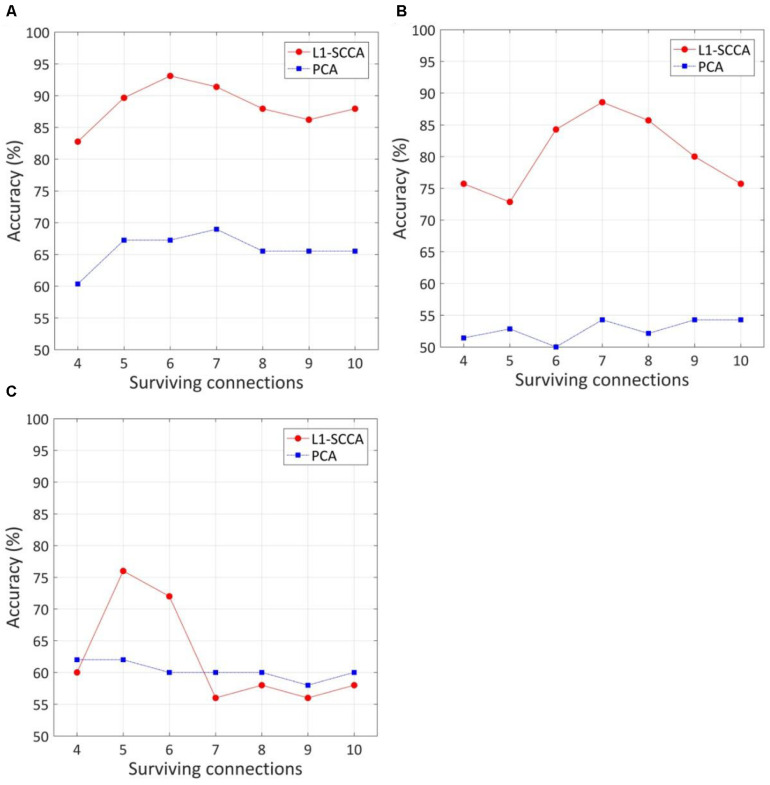
The effect of the number of discriminative connections on prediction accuracy and comparison of our method with feature reduction of principle component analysis (PCA). (A) T2DM-CI versus HC; (B) T2DM-NC versus HC; (C) T2DM-CI versus T2DM-NC.